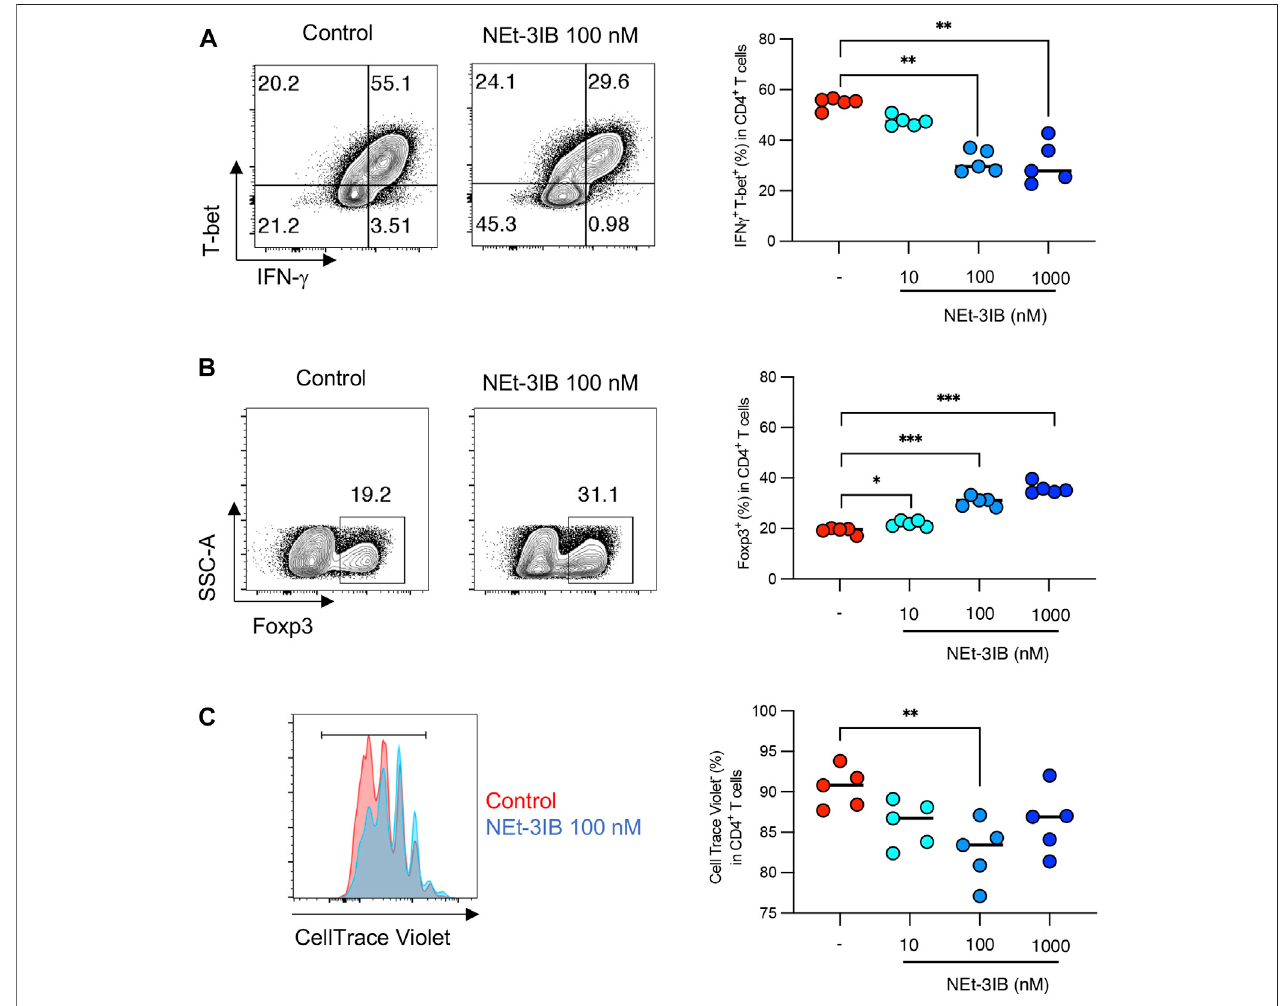
FIGURE 4 | NEt-3IB inhibits differentiation of in fl ammatory T cells and induces Foxp3 + cells in Th1 and Th17 conditions. (A, B) Naïve T cells were cultured in Th1 conditions,withorwithoutNEt-3IBtreatmentfor5 daysandanalyzedforT-betandIFN- γ expression (A) ,andforFoxp3expressionintheCD4 + Tcellpopulation (B) . (C) NaïveTcellswerelabeled withCellTrace VioletandculturedinTh1conditionswithorwithoutNEt-3IB treatment for5 days.Cultured cellswereanalyzed fortheirdegree of proliferation in the CD4 + T-bet + IFN- γ + population. * p < 0.05, ** p < 0.01, *** p < 0.005.